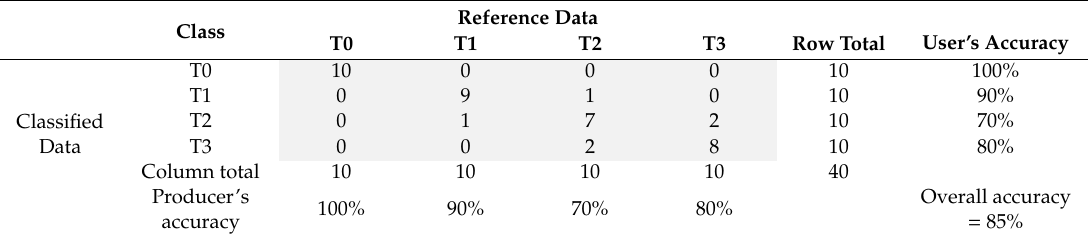
Table 10. Confusion matrix of ensemble subspace discriminant (ESD; input of PC1, PC2, and